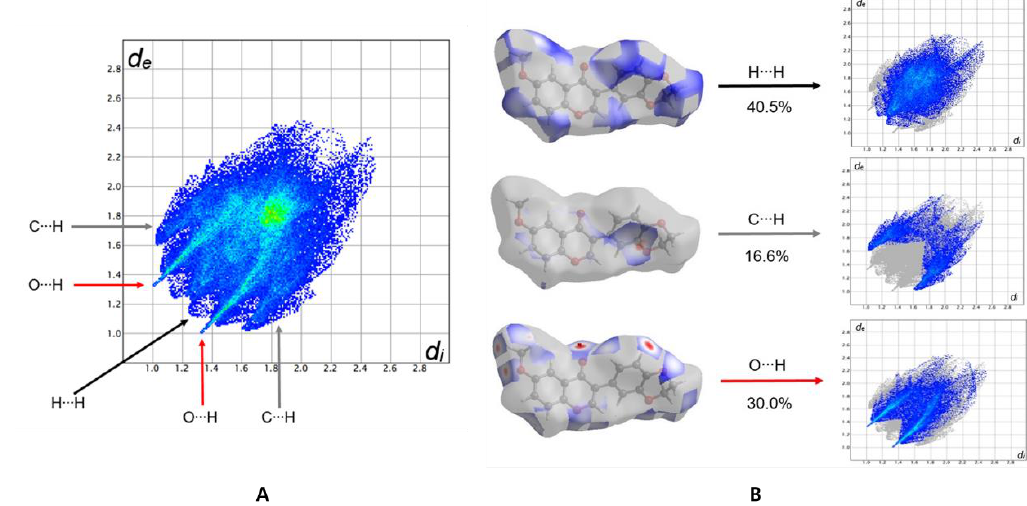
Figure 6. The two-dimensional fingerprint plots for isoflavone 6 , showing all interactions ( A ), and delineated into a major contribution of H···H/H···H, O···H/H···O, C···H/H···C interactions ( B ).